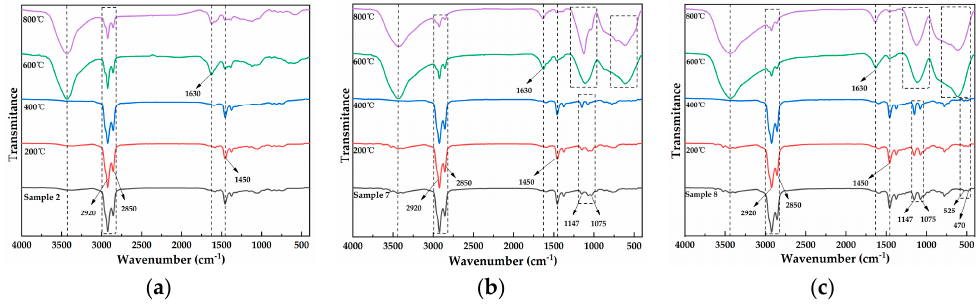
Figure 7. FTIR spectra of residue for asphalt binder at different temperatures: ( a ) Sample 2; ( b ) Sample 7; and ( c ) Sample 8.